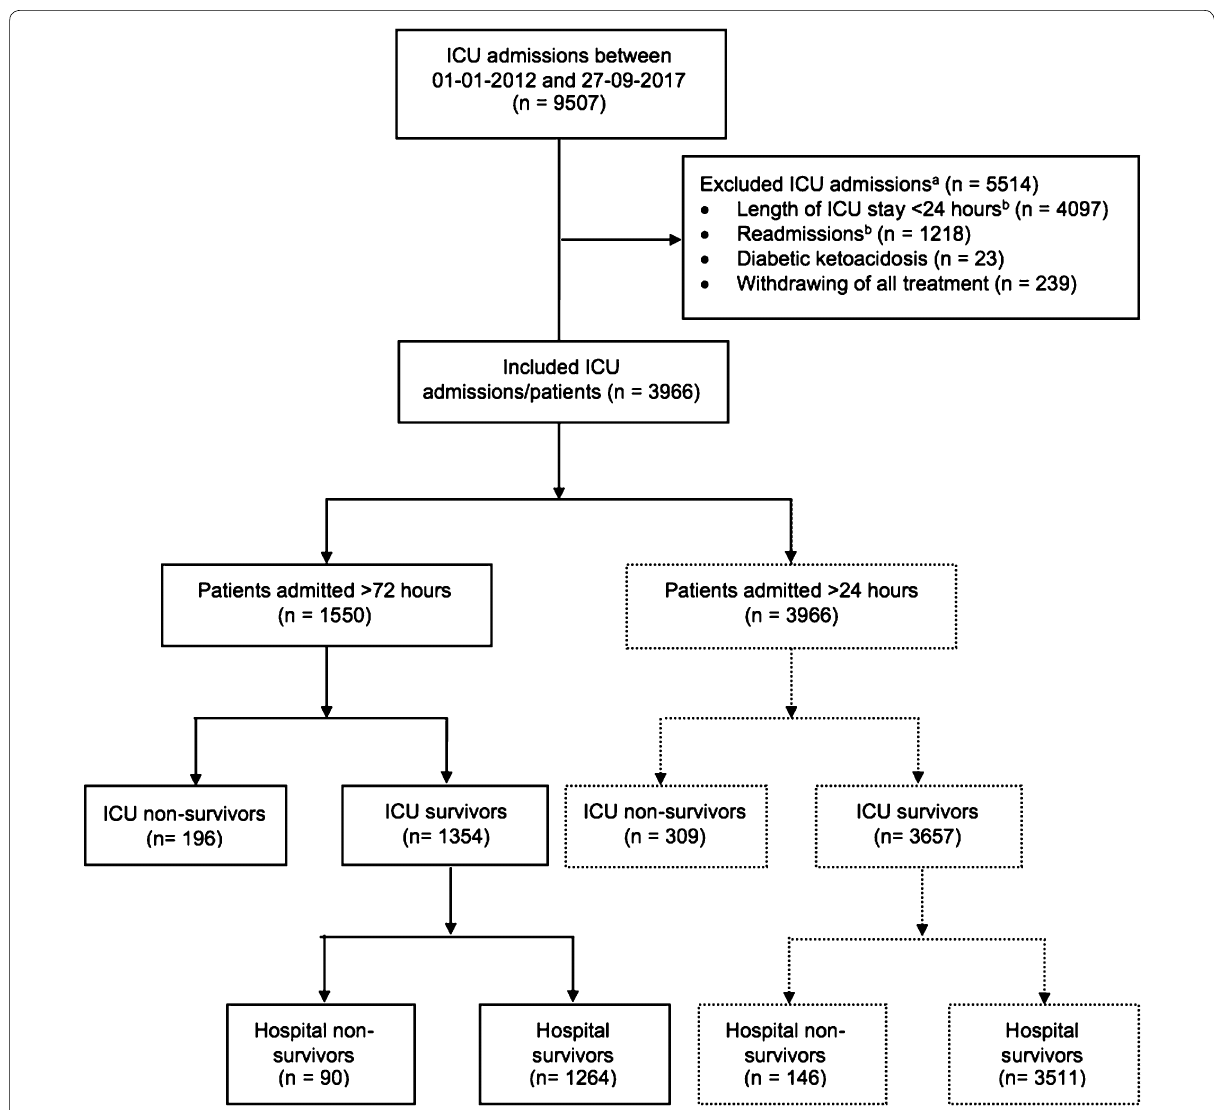
Fig. 1 Patient flow diagram. a Category numbers do not sum up due to overlap between exclusion criteria. b Readmissions are defined as all ICU admissions after the initial admission. ICU intensive care